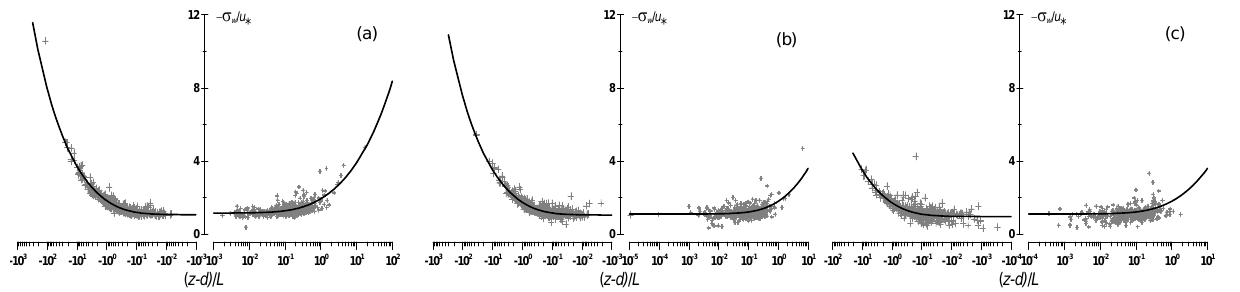
Figure 8. MOS relation of vertical velocity variances of the different scale eddies in NSPCE; (a) , (b) and (c) , respectively, represent the similarity of eddies of 10, 30 and 60min at the temporal scale.